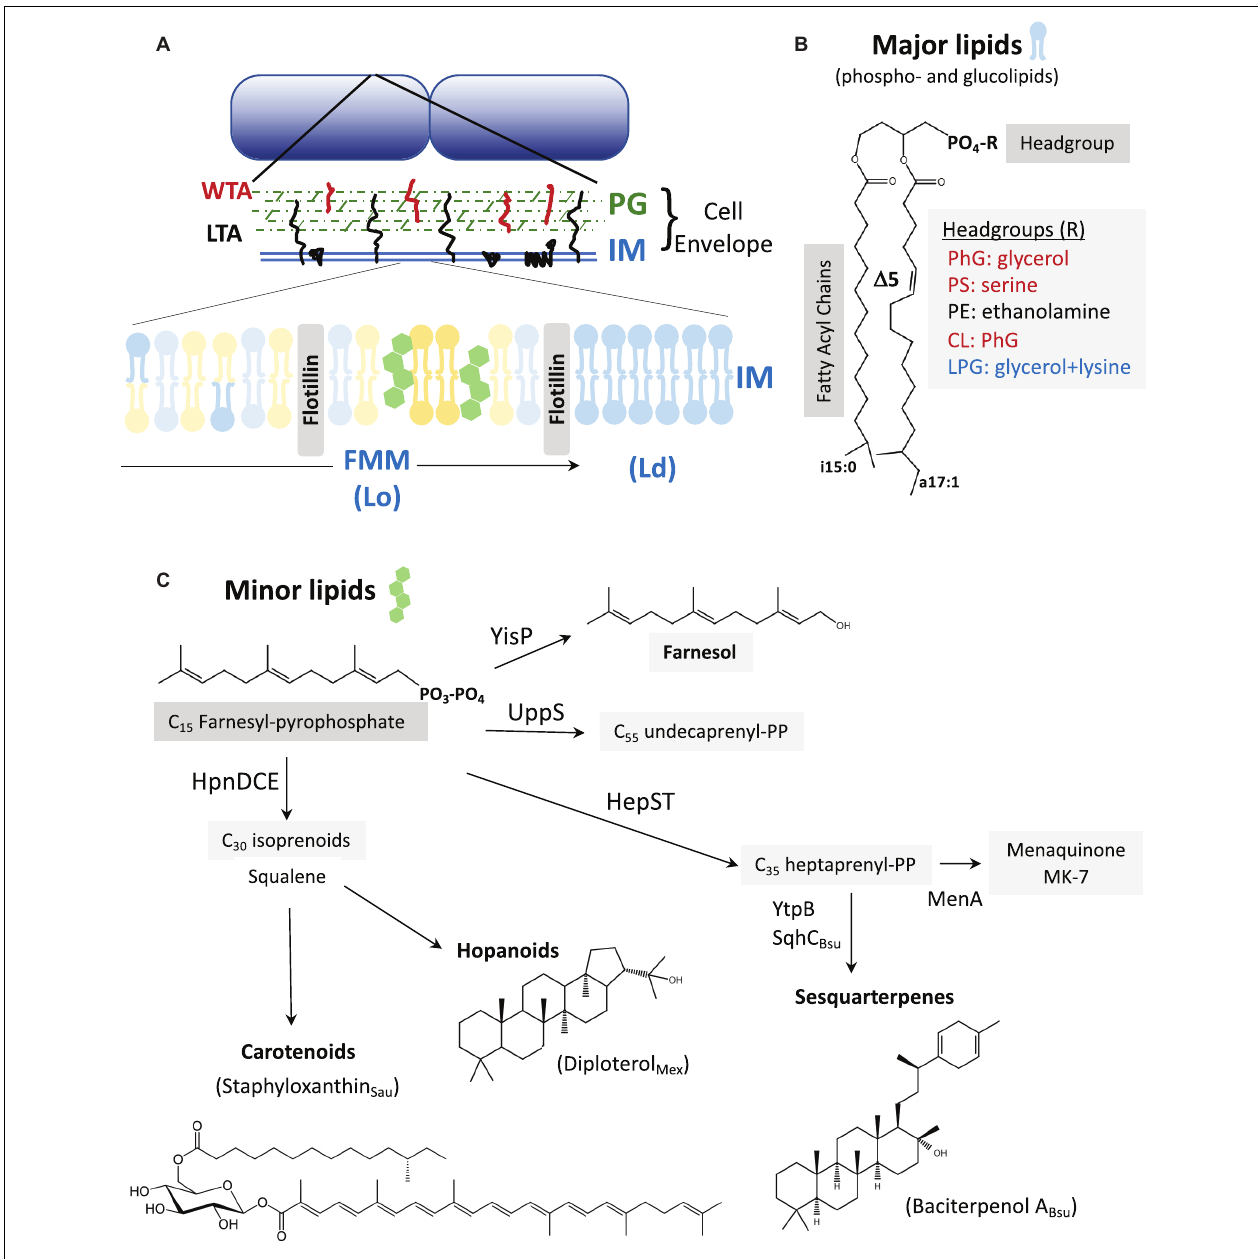
FIGURE 1 | (A) The cell envelope : Bacillus subtilis is surrounded by a cell envelope comprised of a thick peptidoglycan (PG) layer and an inner membrane (IM). The membrane-associated lipoteichoic acid (LTA) and PG-linked wall teichoic acid (WTA) are abundant anionic polymers in the envelope (Rajagopal and Walker, 2017). The IM contains lateral microheterogeneity in the form of functional membrane microdomains (FMMs), regions of liquid-ordered (Lo) membrane together with associated proteins such as flotillins (Lopez and Koch, 2017). These are flanked by regions of higher fluidity characterized as liquid-disordered (Ld). (B) Major membrane lipids : Major membrane lipids include phospholipids and glucolipids (Nickels et al., 2017). Phospholipids (shown) vary in their FA chains, which are largely branched in B. subtilis . Shown here are a C 15 iso-FA and a C 17 (cid:49) 5 (unsaturated) anteiso-FA. Other FA chain lengths (including straight chains), and the positioning of the FA chains on the 1 and 2 positions of glycerol can vary. Variations in the phospholipid headgroups modulate surface charge (red are anionic, blue cationic, and black net neutral). Glucolipids are generally neutral lipids with one or more sugar residues in place of the phosphate shown. (C) Minor membrane lipids : Many of the minor lipids in the membrane are isoprenoids and are derived from the C 15 intermediate farnesyl-pyrophosphate (FPP). FPP is a precursor for undecaprenyl-PP (for PG synthesis) and for the C 35 intermediate heptaprenyl-PP. The latter is a precursor for the electron carrier menaquinone (MK-7) and sesquarterpenes including baciterpenol A and its derivatives (sporulenes) (Bosak et al., 2008; Takigawa et al., 2010; Sato et al., 2011; Sato, 2013). Two FPP can also be coupled in a multistep reaction by HpnDCE to generate C 30 squalene (Pan et al., 2015; van der Donk, 2015), which can be processed into carotenoids [such as staphyloxanthin from S. aureus; (Garcia-Fernandez et al., 2017; Foster, 2019)] or cyclized by squalene-hopene cyclases to generate polycyclic compounds (hopanoids) (Saenz et al., 2015; Belin et al., 2018). In B. subtilis , FPP can also be dephosphorylated by YisP to generate the alcohol farnesol (Bell and Chappell, 2014; Feng et al.,